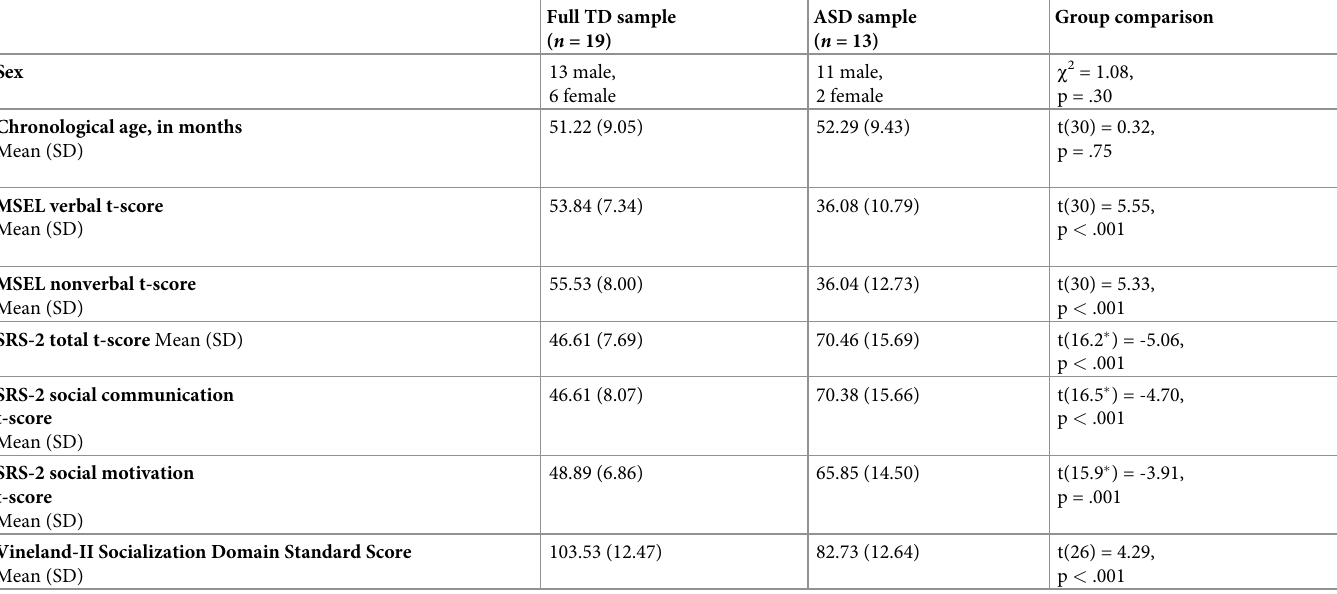
Table 1. Participant